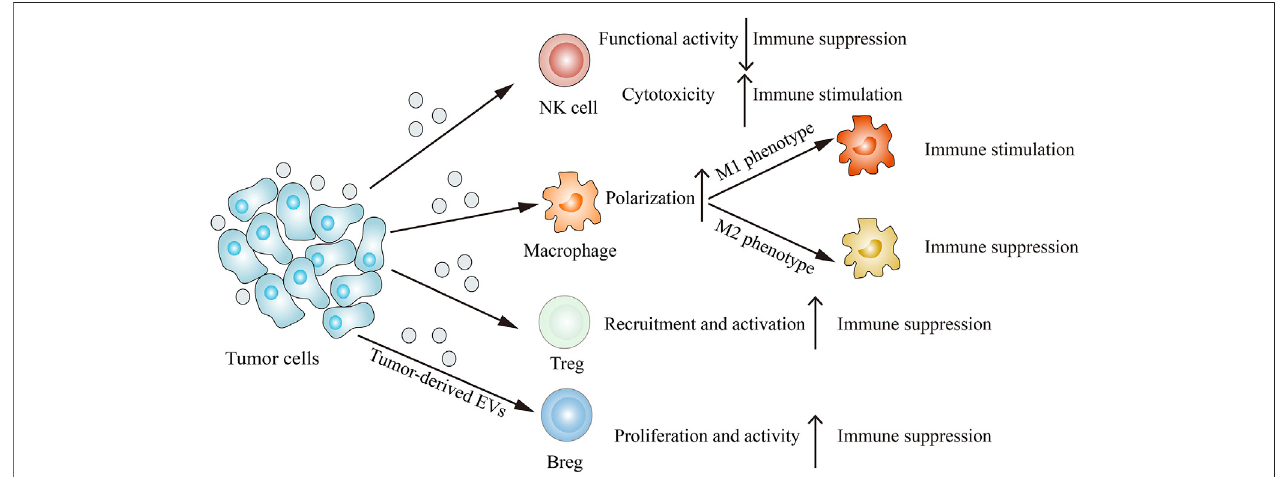
FIGURE 3 | Tumor-derived EVs modulate the immune system. Tumor-derived EVs can suppress NK cells functional activity, induce M2 macrophage polarization, recruit Tregs and proliferate Bregs, thus inhibiting immune response. On the other hand, tumor-derived EVs can also enhance NK cells cytotoxicity and induce M1 macrophage polarization, thereby stimulating immune